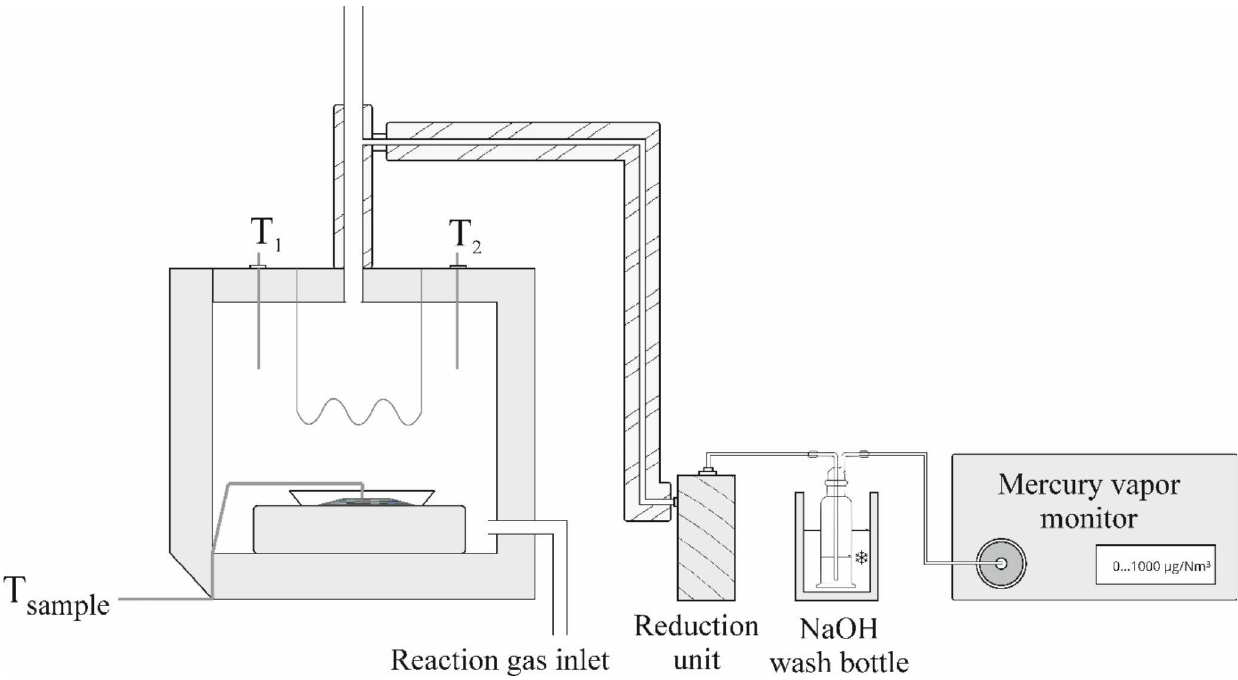
Fig. 1 Schematic high-temperature furnace for mercury release